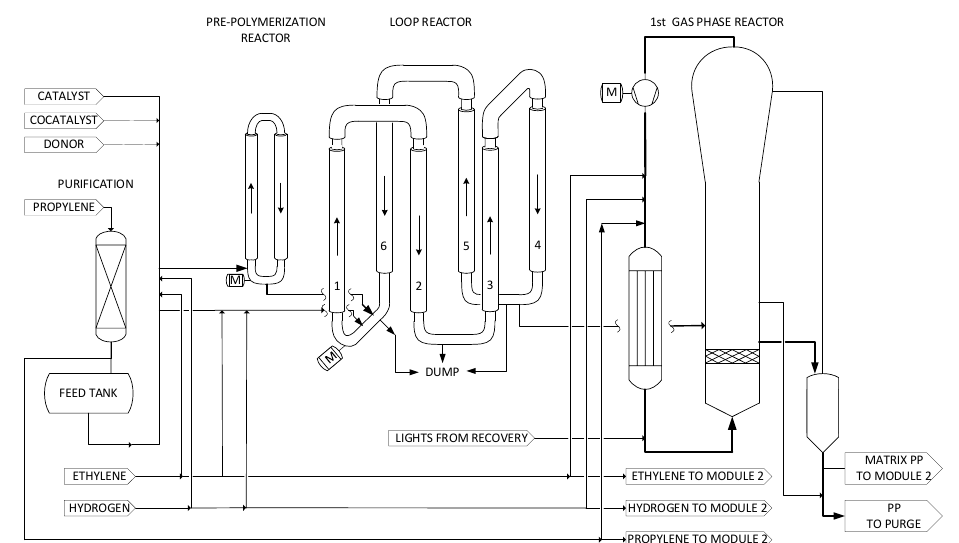
Figure 2. Simplified schematic flow diagram of reactor module 1 and feeding of the Borstar ® PP process.